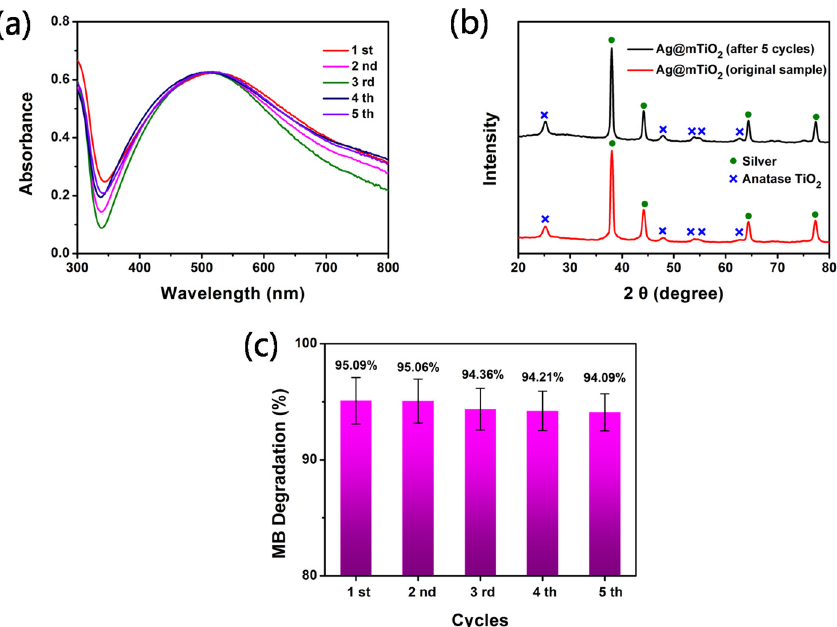
Figure 6. ( a ) UV-vis spectra of Ag@mTiO 2 dispersion in water after MB degradation reaction for 5 consecutive cycles. ( b ) XRD patterns of Ag@mTiO 2 nanoparticles before and after 5 consecutive cycles. ( c ) The degradation ratio of MB with 5 consecutive cycles.